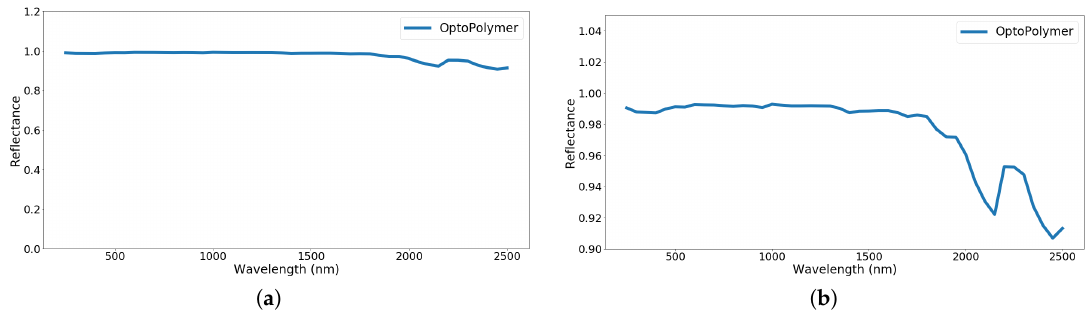
Figure 10. ( a ) Optopolymer reflectance response. ( b ) Optopolymer reflectance zoomed in.